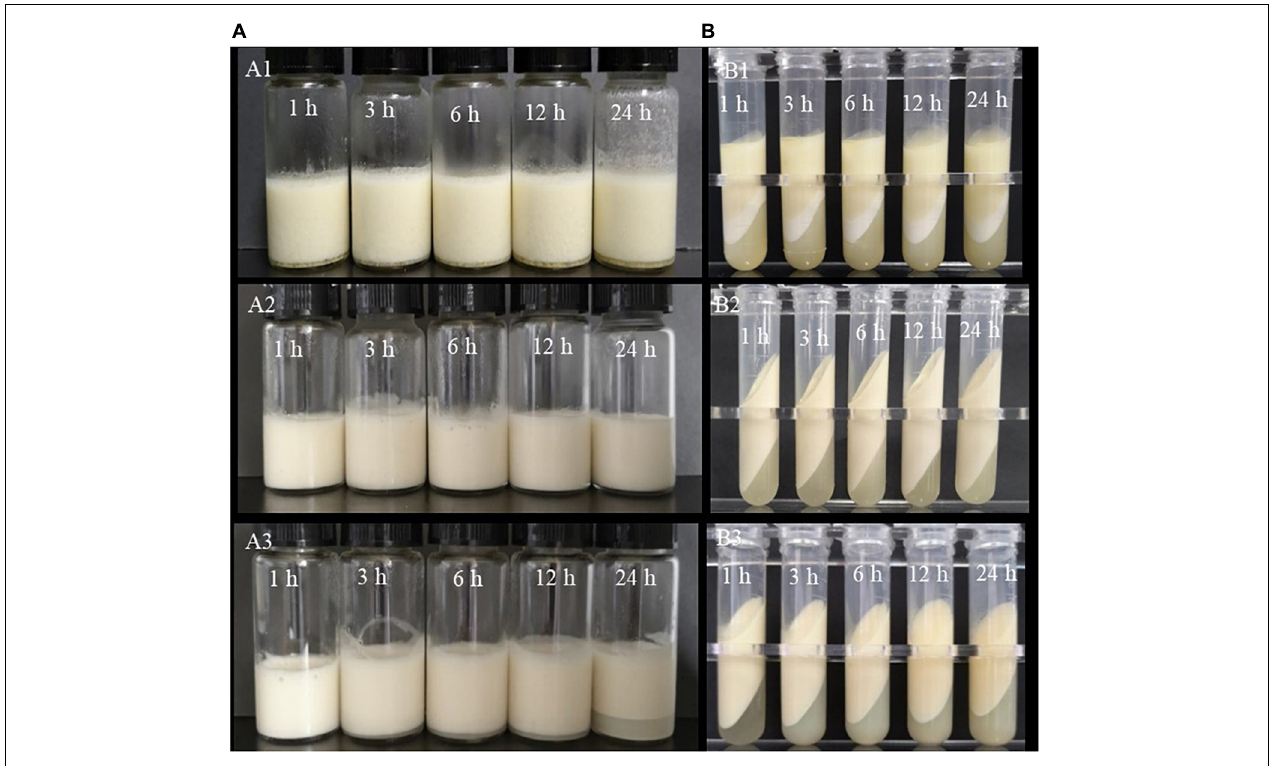
FIGURE 1 | Morphology (A1–A3) and centrifugal stability (B1–B3) of Pickering emulsions stabilized by ZKCPs, ZLCPs, and ZLKCPs; 1, 3, 6, 12, and 24 h stood for the pre-mixing